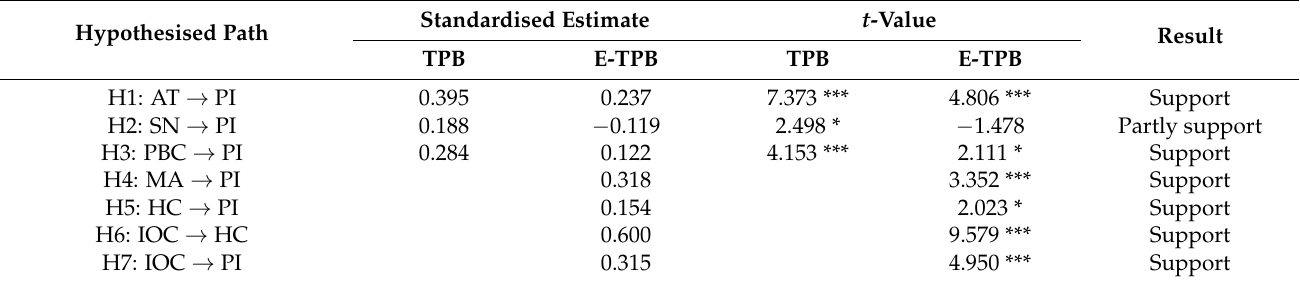
Table 6. Hypotheses test